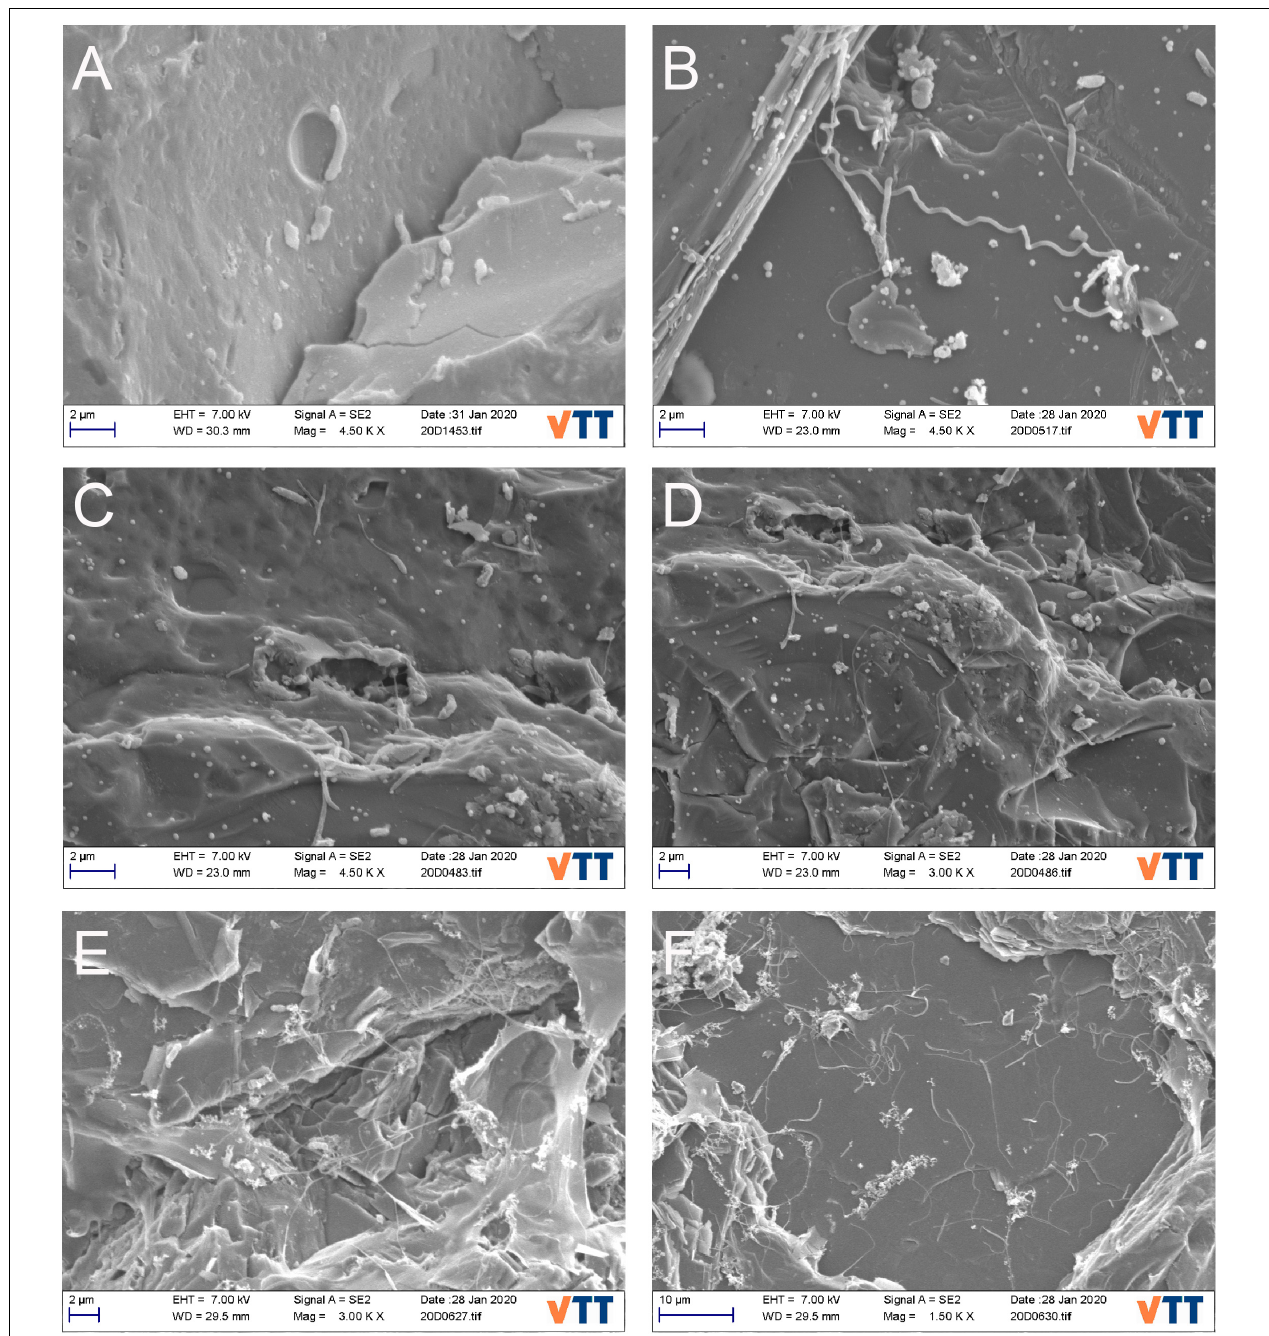
FIGURE 2 | (A–F) SEM images for mica schist slide surfaces after 40-month incubation. (A) Rod-shaped putative microbial cells and potential pitting, (B) potential spirochaeta-like bacterial cell on mica schist surface, (C,D) attached putative stalk forming microbial cells and formed pits on surface of mica schist slides, (E,F) potential EPS on mica schist surfaces and sessile stalked microbial communities.